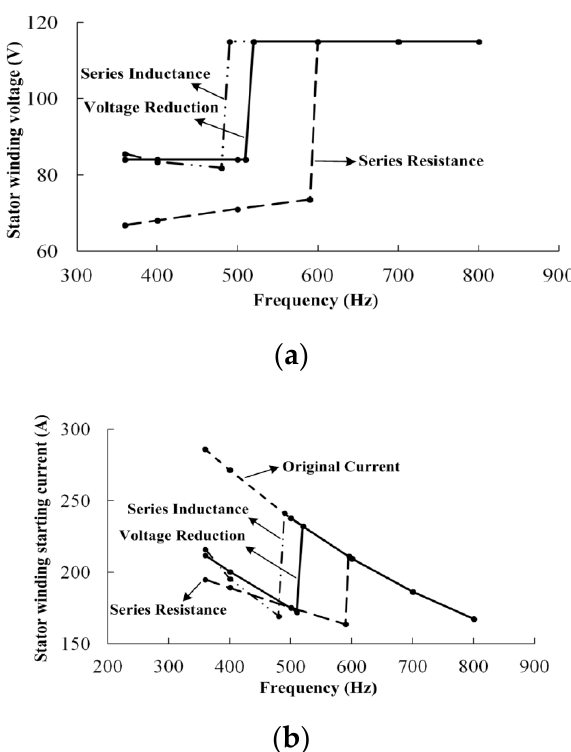
Figure 8. Comparison of voltage and current characteristics. ( a ) Stator winding voltage ( b ) Stator winding starting current.